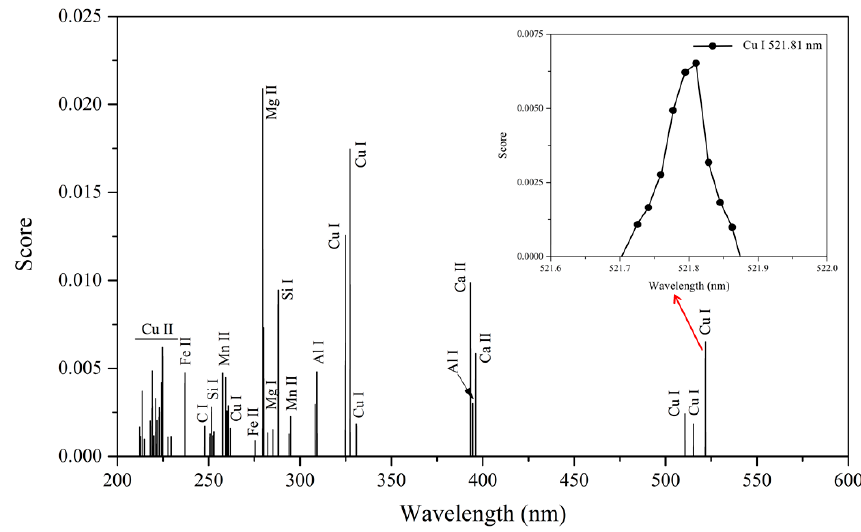
Figure 4. Scores of 300 highest ranked spectral pixels and pixels constituting Cu I 521.81